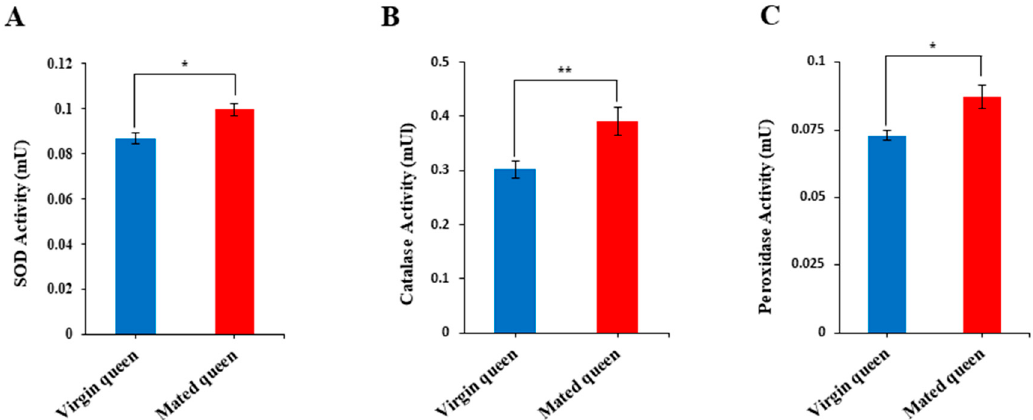
Figure 5. SOD ( A ), catalase ( B ), and peroxidase ( C ) activities in the spermathecal fluid of virgin and mated queens. The bars represent the mean ± SD values. * p < 0.05 and ** p < 0.01.